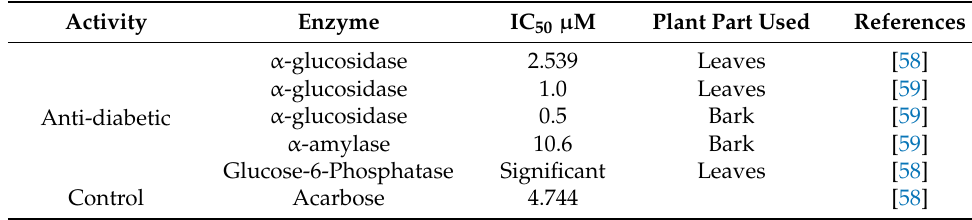
Table 7. Anti-diabetic potential of different parts of P. guajava . Activity Enzyme IC 50 µ M Plant Part Used